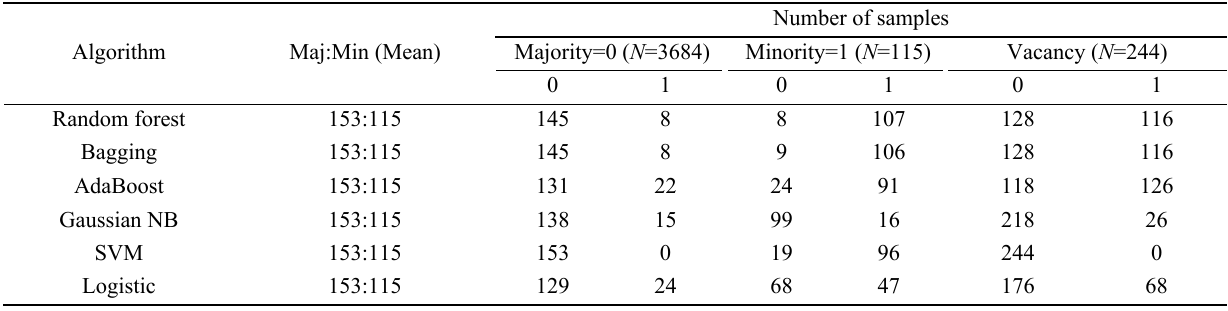
Table 12 Comparing bagging, boosting, Gaussian NB, and SVM (24-split subsample 377 control variables). Algorithm